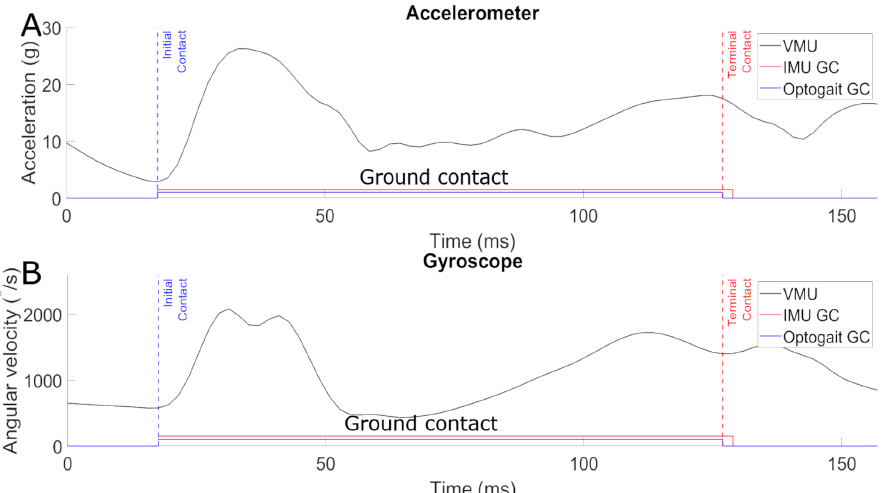
Figure 2. Vector magnitude unit (VMU) of x, y, and z acceleration ( A ) and angular velocity ( B ) throughout one single sprint step. The blue dashed line marks the initial contact event; the red dashed line the terminal contact. The solid red line indicates the resulting ground contact period for the inertial measurement unit (IMU). The photo-electric-measured (Optogait) ground contact time is represented by the solid blue